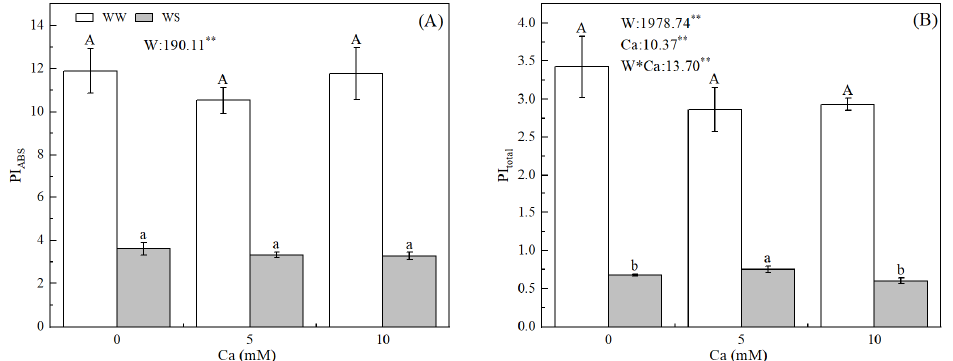
Figure 8. Effect of well water (WW), water stress (WS), and different calcium (Ca) on PI ABS (perfor- mance index, A ) and PI total (total performance index, B ). The capital letters indicated a significant difference at 0.05 among well water treatments. Moreover, the little letters indicated a significant difference at 0.05 among water stress treatments. The single * in the upper right corner indicated a significant effect at 0.05 level, and the double * indicated a significant effect at 0.001 level. F is not provided when Ca, W, and their interactions are not significant. PI ABS = (RC/ABS) ( ϕ Po/(1 − ϕ Po)) − ( ψ o/(1 − ψ o)), PI total = (RC/CS) (